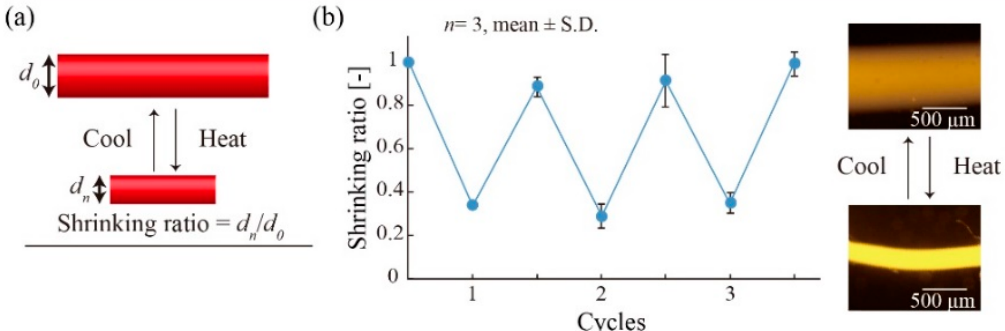
Figure 7. Responsivity of the polymerized hydrogel to thermal stimuli. ( a ) Definition of the shrinking ratio d n / d 0 . Shrinking ratio is obtained by the diameter of the polymerized printed ink after being heated or cooled divided by the initial diameter of the polymerized printed ink before stimuli. ( b ) The repeatability of shrinking / swelling behavior of the polymerized printed ink. The polymerized printed ink shrunk or expanded according to heating or cooling.